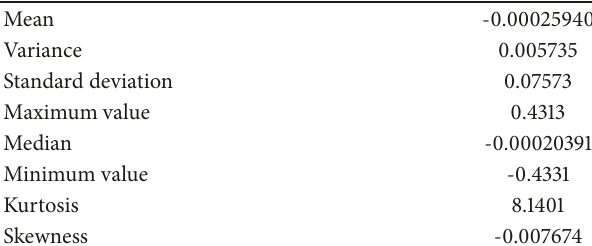
Table 5: Descriptive statistics of the return